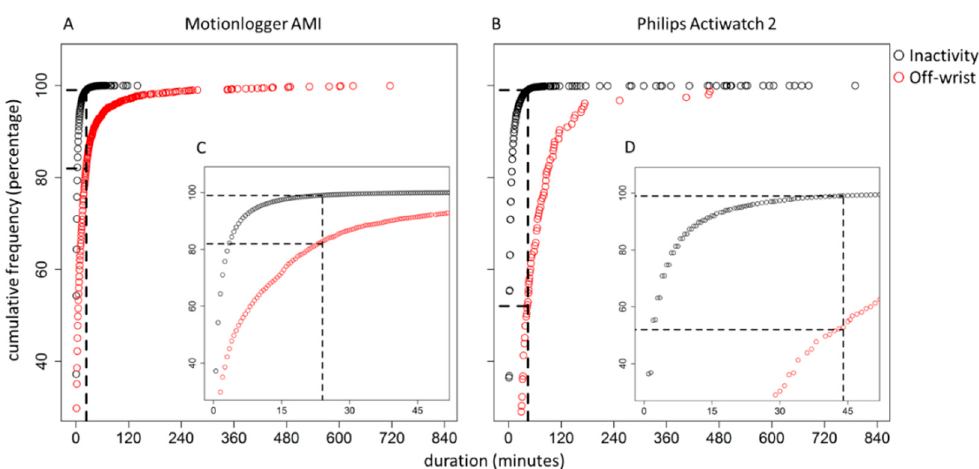
Figure 1. Cumulative frequency plots indicating the duration of consecutive strings of data marked as ‘inactivity’ or ‘off-wrist’. Both the complete distribution of inactivity ( A , B ) and off-wrist periods ( C , D ) for the Motionlogger and Actiwatch 2 are presented. Black circles represent data marked as inactivity, while red dots indicate off-wrist periods. Vertical dotted black lines indicate 99% correctly identified inactivity data of the Motionlogger and Actiwatch. Data left of the vertical line indicate inactive data correctly identified as such and off-wrist data incorrectly identified as inactivity. Data to the right of the dotted lines indicate inactivity data incorrectly identified as off-wrist, and off-wrist data correctly identified as such.